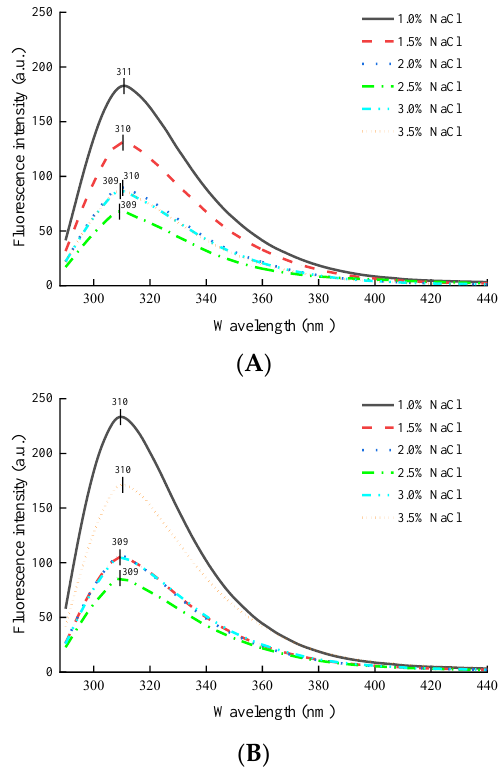
Figure 3. Effects of different NaCl concentrations on intrinsic fluorescence of SG ( A ) and MG ( B ).